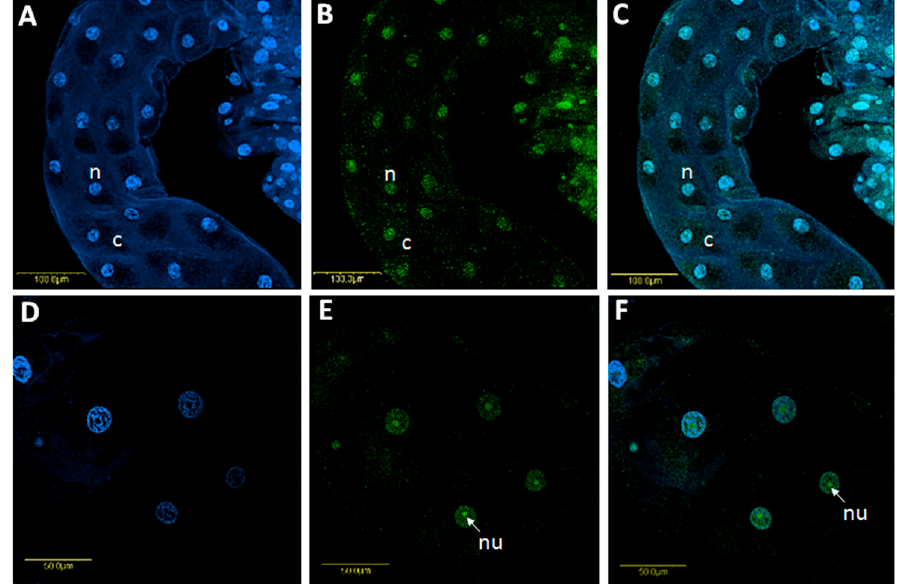
Figure 4. Localization of Sodalis in B. trigonica midgut using fluorescent in situ hybridization (FISH) with a Sodalis- specific probe. A and D : DAPI staining of BT midgut nuclei (blue). B and E : Localization of Sodalis (green) inside B. trigonica midguts by FISH, mostly showing specific localization inside the nucleus and the nucleolus and some localization in the cytoplasm around the nucleus. C and F : Overlay of Sodalis and DAPI staining inside midgut nuclei under a bright field. Arrows indicate, n: nucleus; nu: nucleolus; c: cytoplasm.